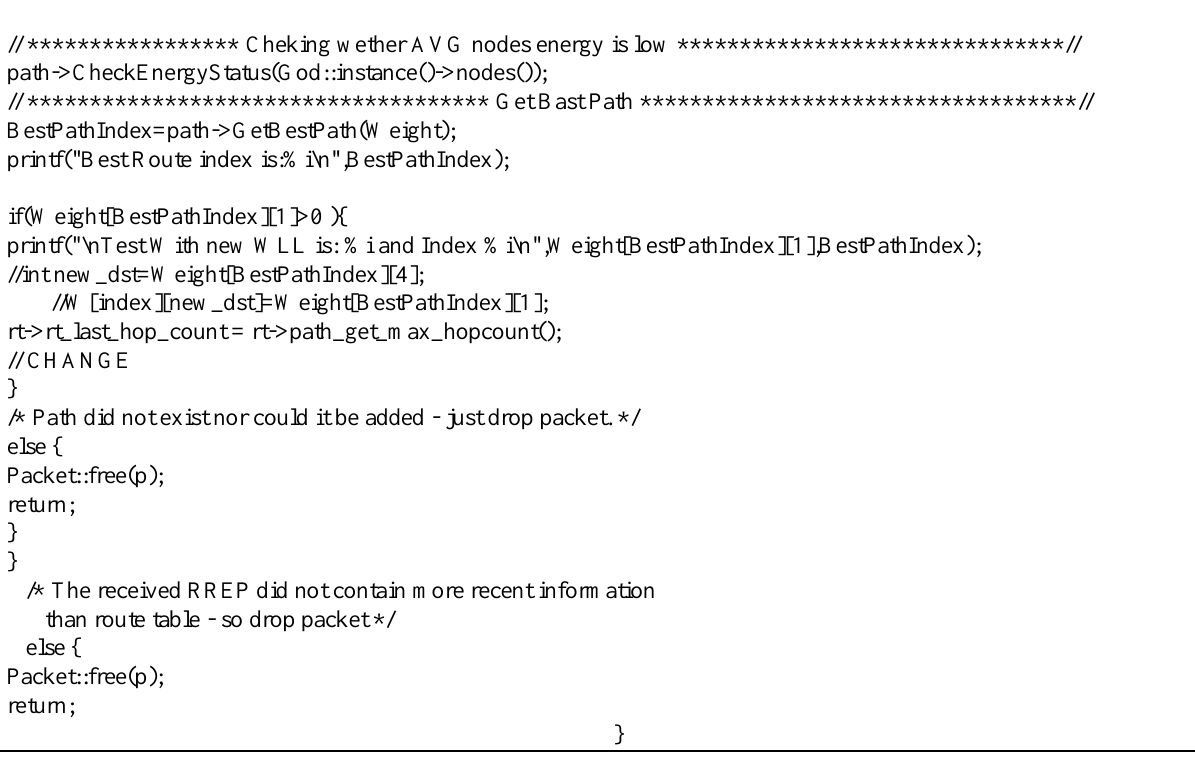
Fig. 4. The path searching algorithm in proposed protocol of AOMDV-F